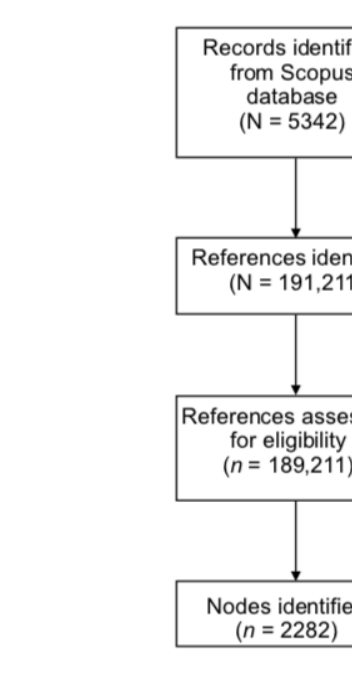
Figure 1. Preferred Reporting Items for Systematic Reviews and Meta-Analyses (PRISMA) flowchart for literature search and reference